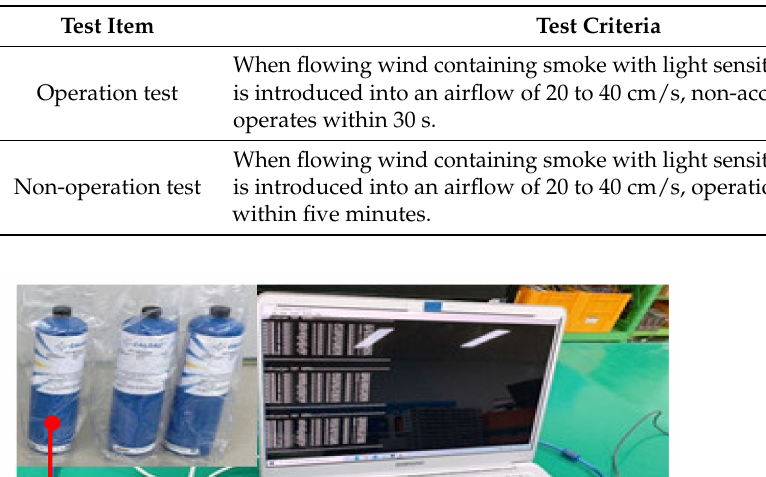
Figure 4. Chamber for the KFI experiment. Table 3. Photoelectric sensor sensitivity test regulations.